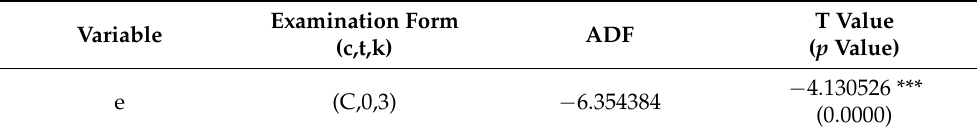
Table 4. Test results of residual sequence stationarity.